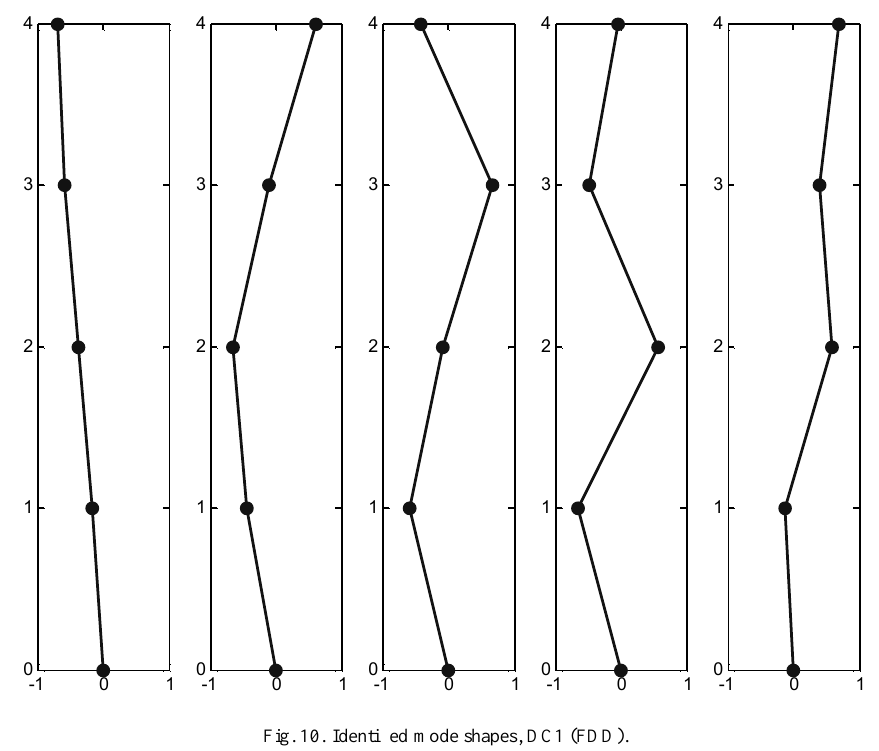
Fig. 10. Identified mode shapes, DC1